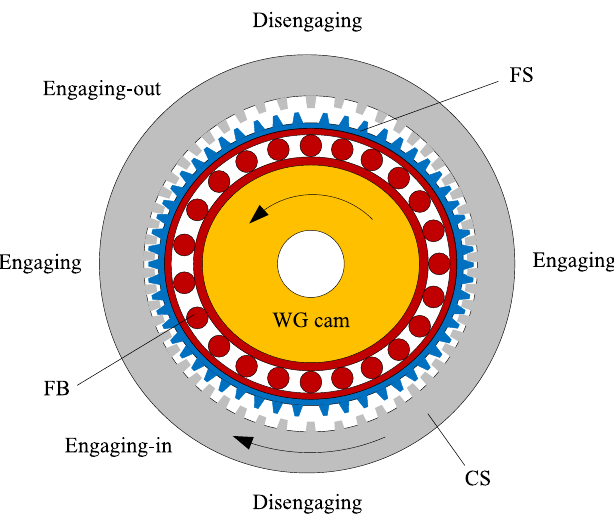
Fig. 1. Schematic diagram of the working principle of the harmonic